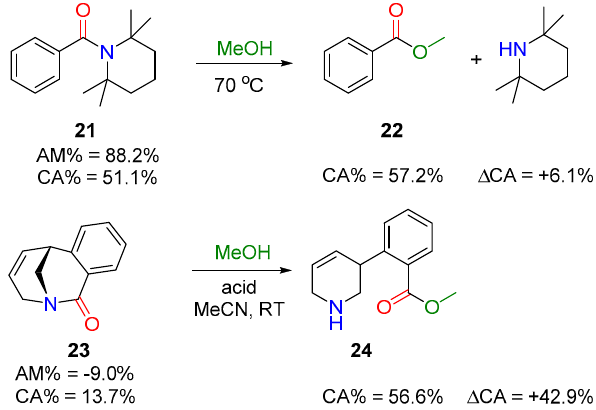
Figure 11. Relevant examples for acyl transfer reactions in the cases of distorted ( 21 ) and twisted amides ( 23 ) resulting esters ( 22 and 24 ), explained by the change in carbonylicity (CA%) with the corresponding carbonylicity and amidicity values computed at B3LYP/6-31G(d,p) level of theory.